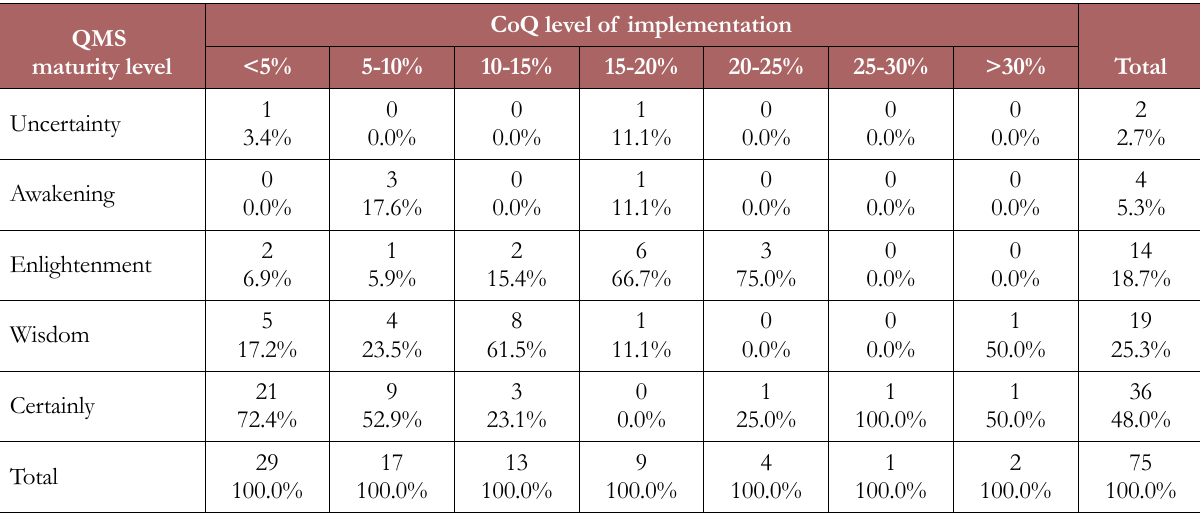
Table 10. CoQ Scale * QMS Maturity level